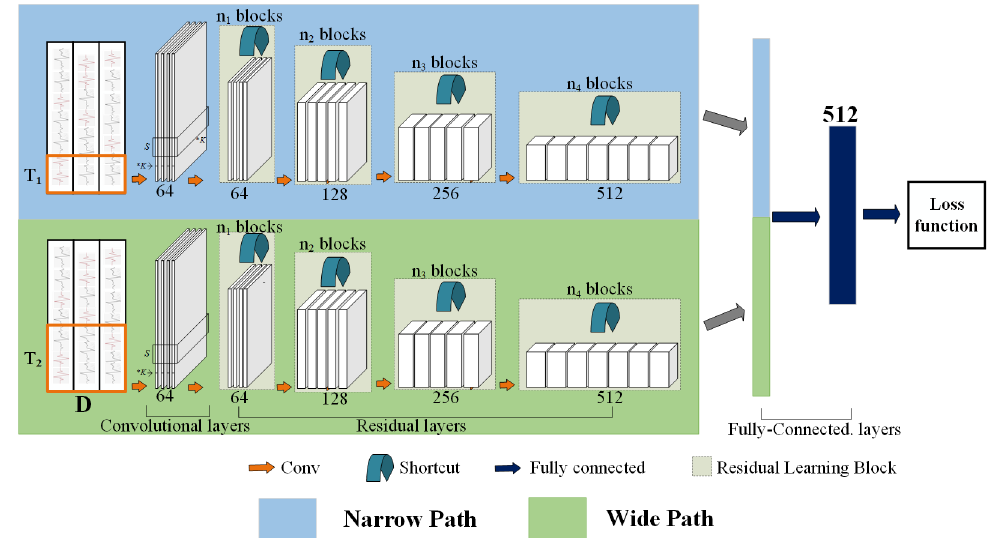
Figure 6. The proposed ARN architecture for human activity recognition. T 1 and T 2 in the raw data layer denote the length of the time window corresponding to the narrow path and wide path, respectively ( T 1 < T 2 ). D denotes the number of sensor channels. In the conv. layers, K denotes the kernels in the layer, and the length of kernels is s = 5. In the res. layers, the dimension of each block doubles feature maps to the input signal, which is processed by a number of preset building blocks for residual